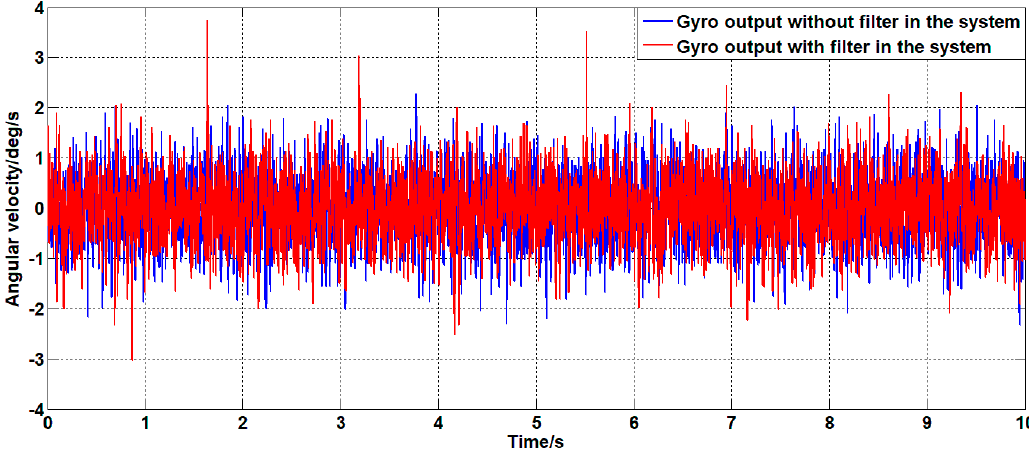
Figure 24. The angular velocity curve of the system output with or without a filter.